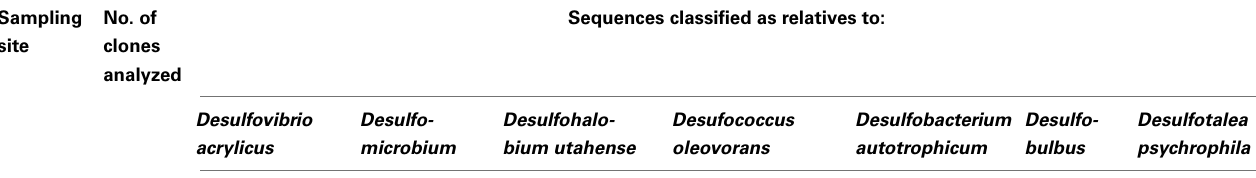
Table 2 | Gene dsrA clone library data for three sediment samples of the Peru margin and four sediment samples of the Black